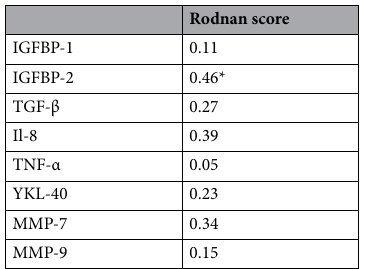
Table 4. Correlation between sputum biomarkers and clinical scores in SSc group. Spearman correlation: p <